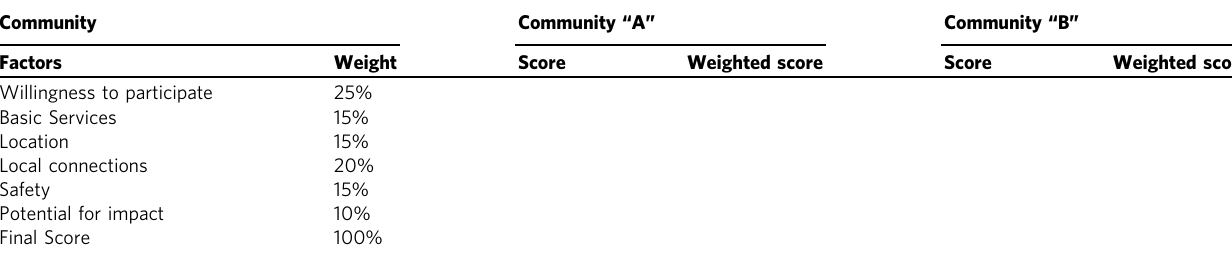
Table 1 Ranking factors table.